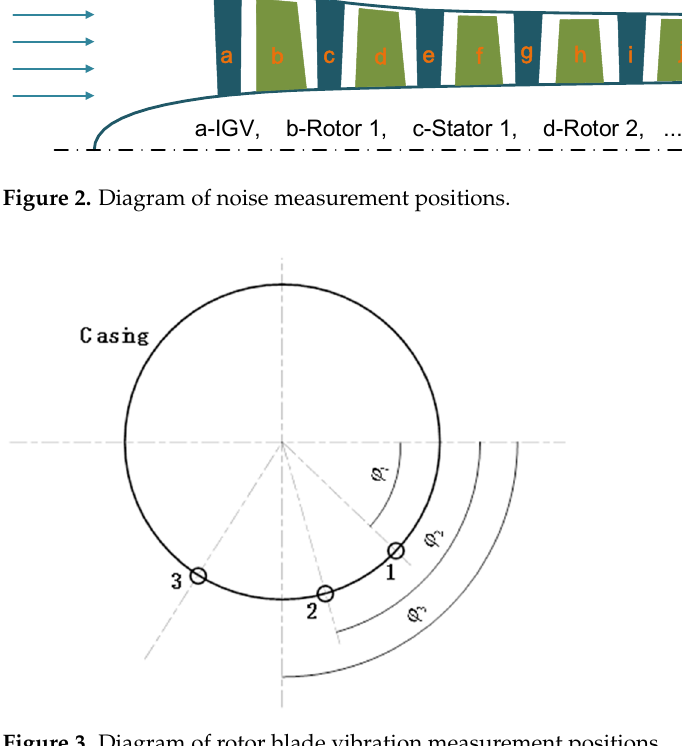
Figure 4. The change of noise signal spectrum before and after rotor blade abnormal vibration. It can be seen from Figure 4 that the internal noise spectrum of the compressor pre- sents typical broadband noise characteristics, and there are several characteristic frequen- cies with discrete pure sound components. It is obvious that the pure sound component appears at 1402 Hz when the abnormal vibration of high-amplitude value occurs in the